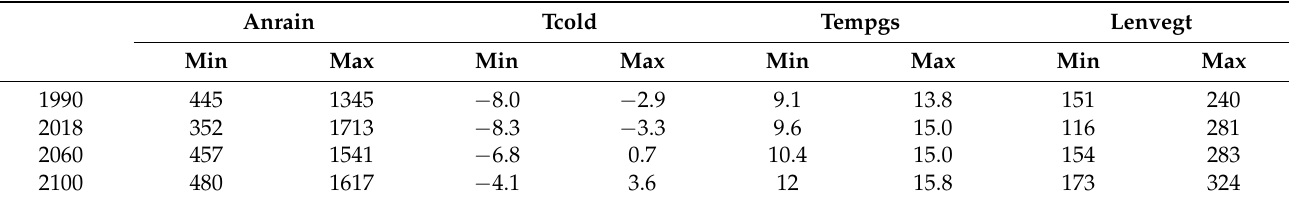
Table 2. Summary statistics of the main climate indices for 1990 and